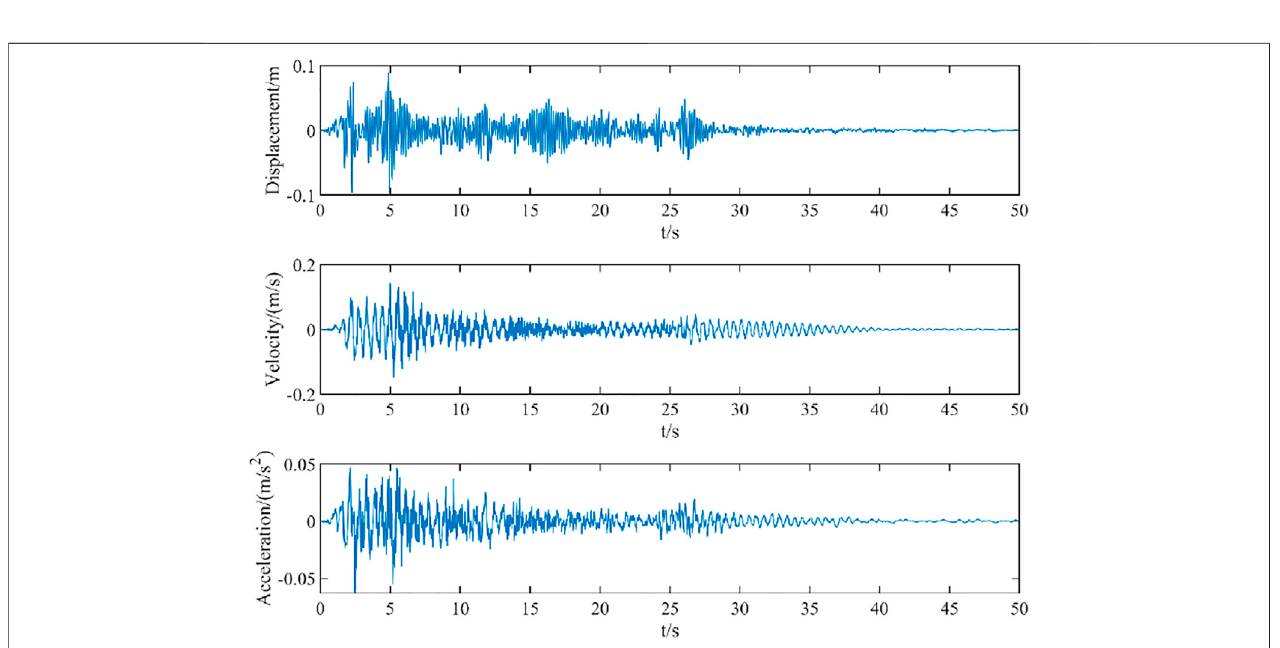
FIGURE 8 | Dynamic response of displacement, velocity, and acceleration output of damage model of simply supported beam.